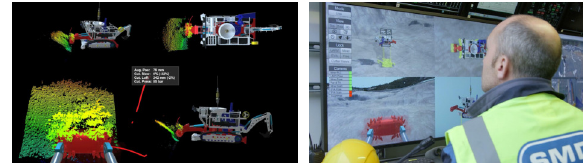
Figure 7. Split-views for piloting the mining vehicle during cutting operations. The view point for each split view can be adjusted